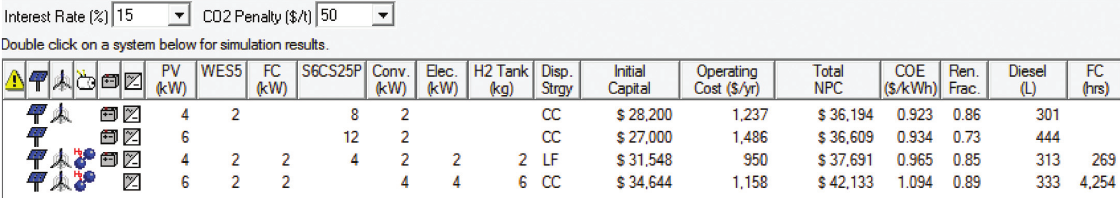
Figure 14: Results of simulation for 15% real interest rate and $50/t emission penalty.